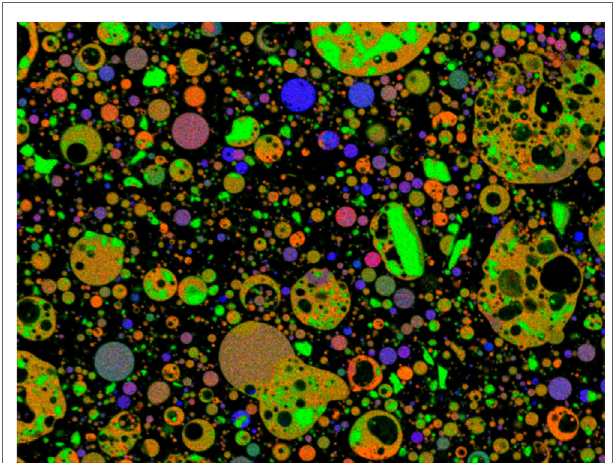
FigUre 2 | Ml fly ash displayed as viewed in Multispec with red for aluminum; green for silicon; and blue for calcium; blended phases are represented by colors, such as orange, purple, and